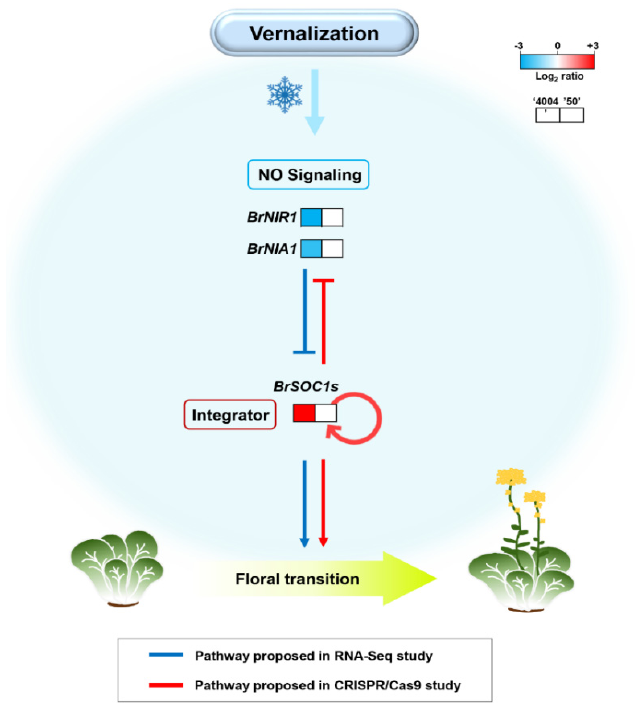
Figure 8. Schematic representation of the gene regulatory network controlling flowering time via interactions between nitrogen signaling and SOC1 response to vernalization in Chinese cabbage. The model is based on data obtained by qPCR and RNA-seq. The gene expression levels were normalized to the expression levels in line “50” after vernalization. Red indicates higher expression, and blue indicates lower expression relative to line “50” after 35 days of vernalization. Arrows indicate transcriptional activation, whereas bars indicate reciprocal transcriptional repressions. A red circular arrow indicates positive feedback regulation.